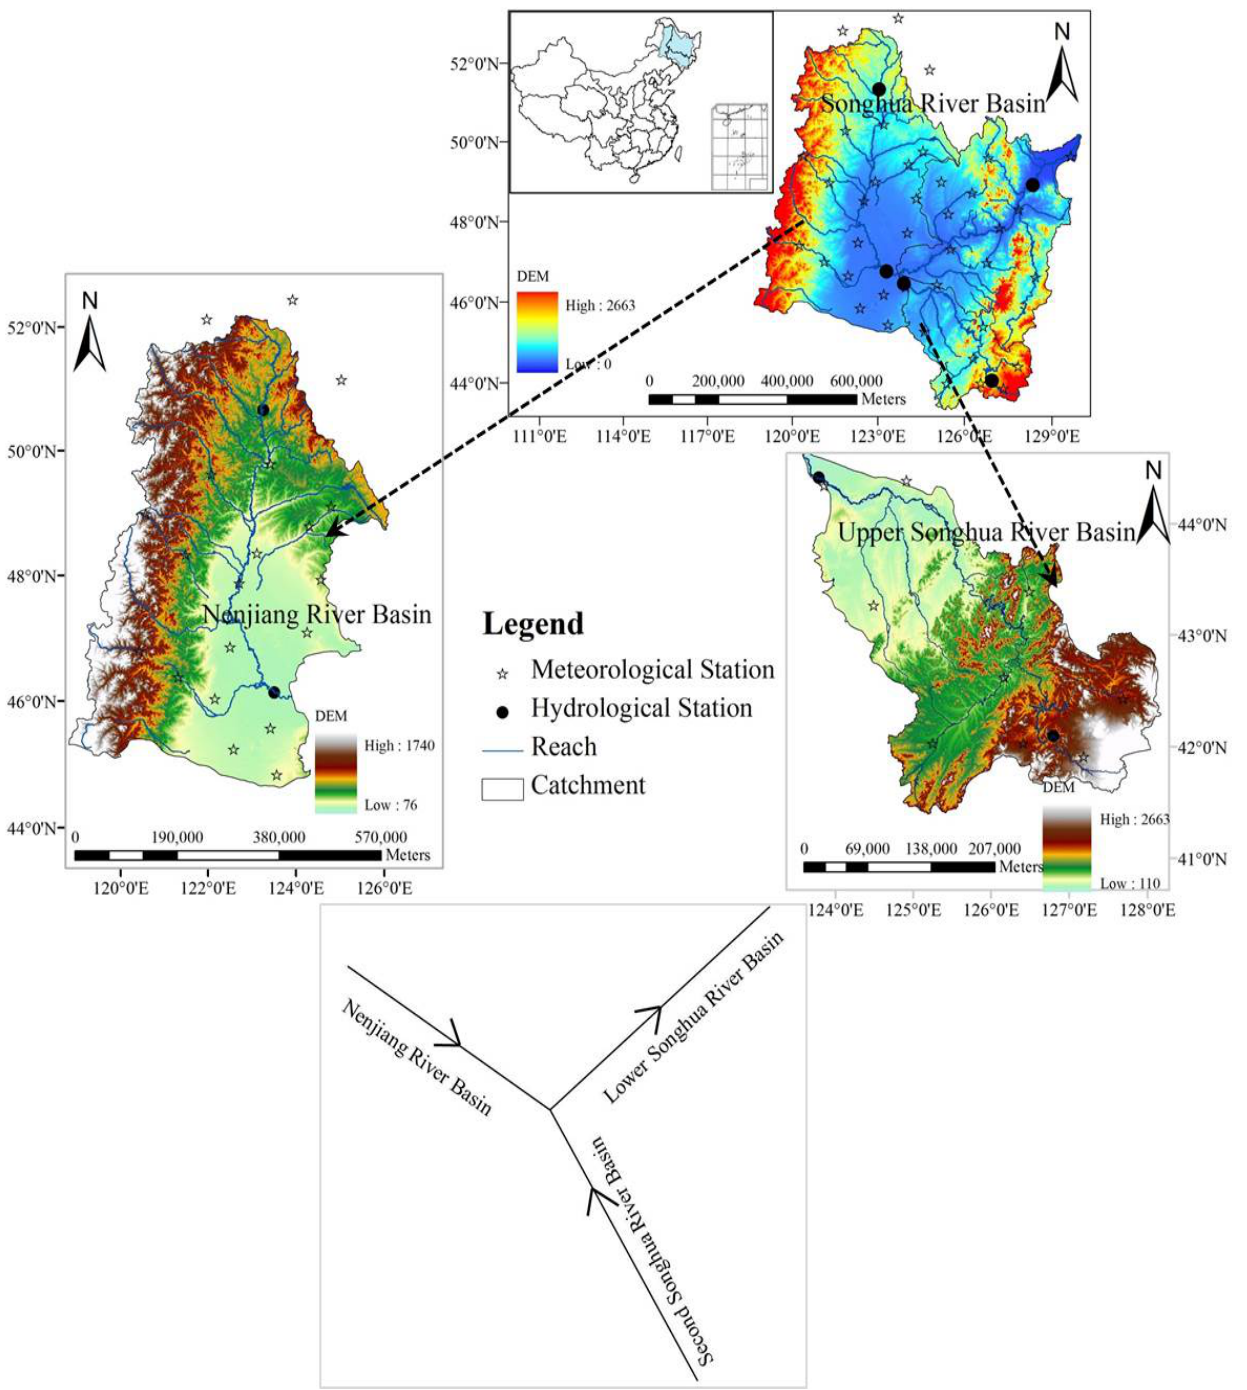
Figure 1. The Songhua River Basin and its two tributary basins (the Nenjiang River Basin and the Second Songhua River Basin) in northeast China and the gauge (dots) and meteorological (stars) stations used in this